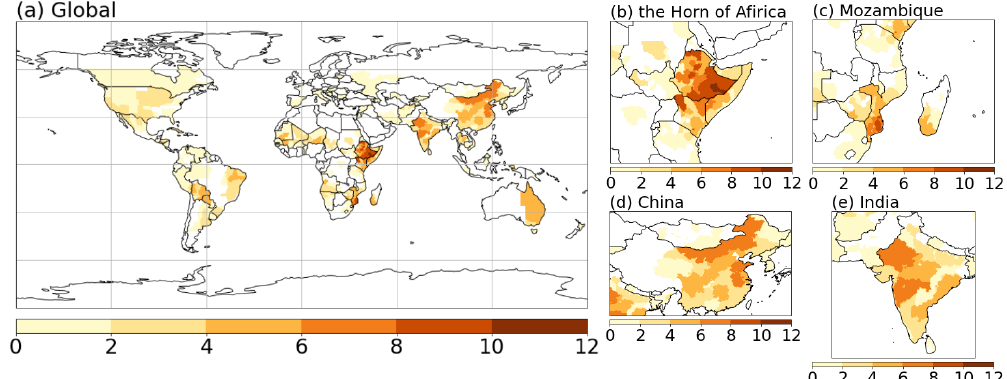
Figure 6. The number of drought events based on GDIS. (a) Global map, with a magnified view of (b) the Horn of Africa, (c) Mozambique, (d) China, and (e) India.